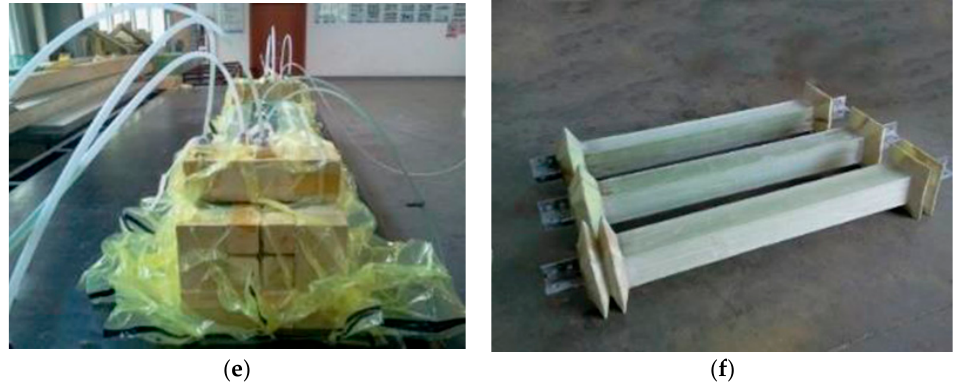
Figure 5. Vacuum-infused molding: ( a ) wood mold; ( b ) spraying the silica gel; ( c ) expansion joint fillers; ( d ) polyurethane foam-wrapped fiber cloth; ( e ) importing the resin; and ( f ) molded specimen.